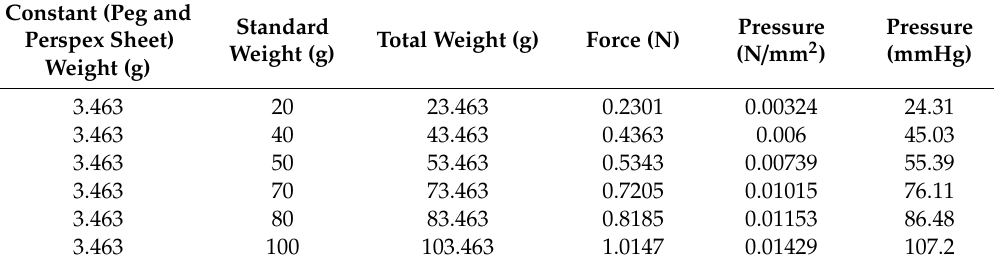
Figure 2. Calibration procedure for FlexiForce ® sensors ( a ) placement of the Teflon peg (white) and the Perspex sheet (x: the set of standard weights, y: Teflon peg). ( b ) The demarcations of different weights on the sheet (p: Perspex sheet, q: demarcations). Table 1. The calibration points used with FlexiForce ® sensors using standard weight. Constant (Peg and Perspex